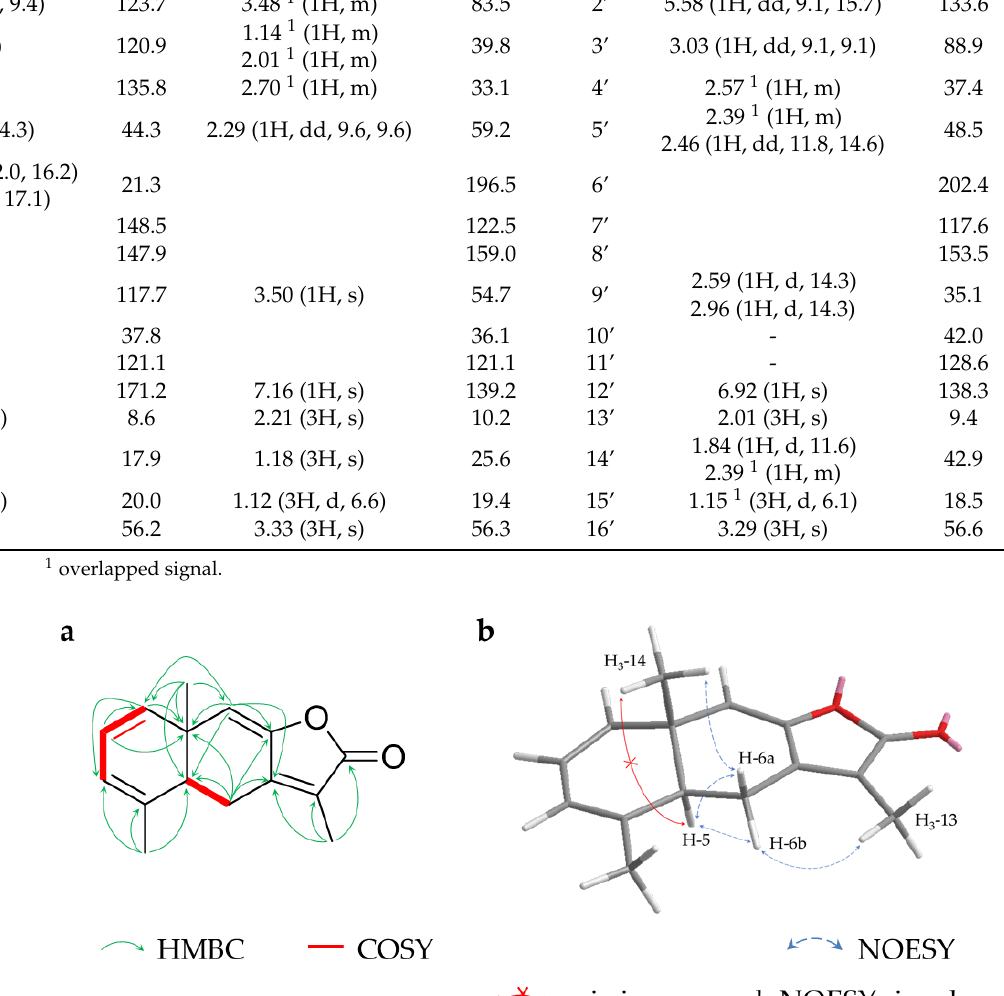
aliphatic including the spiro carbon ( δ C 36.1 (C-10), 42.0 (C-1 0′ )), six were aromatic ( δ C 122.5 (C-7), 159.0 (C-8), 121.1 (C-11), 117.6 (C- 7′ ), 153.5 (C- 8′ ), 128.6 (C-1 1′ )) and two were carbonyl carbons ( δ C 196.5 (C-6), 202.4 (C- 6′ )) (Table 3).